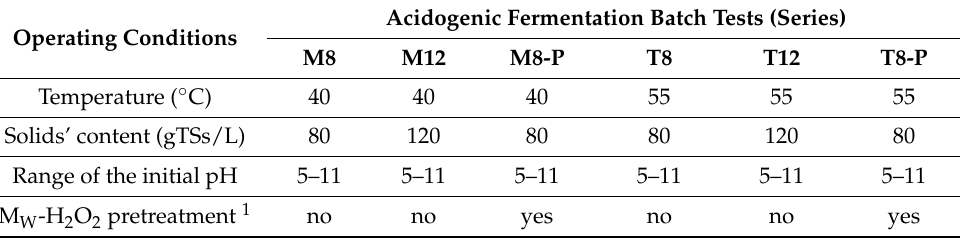
Table 1. Summary of the operating conditions investigated in the batch tests and the assigned names. Operating